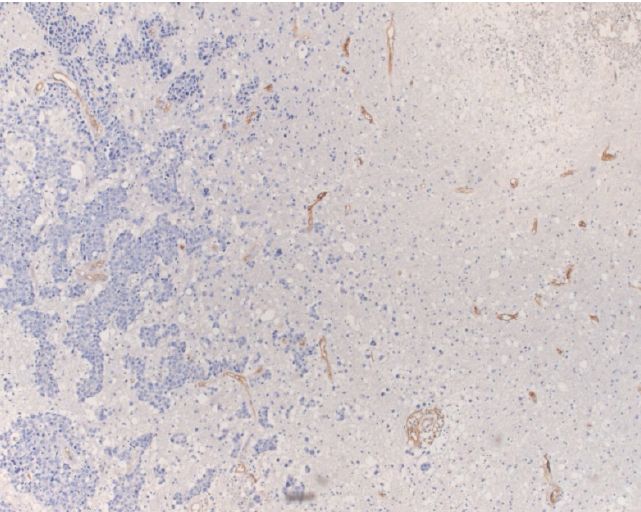
Figure 2. Endoglin-stained vessels in the brain parenchyma adjacent to a BM from pulmonary large cell carcinoma (endoglin stain; original magnification;